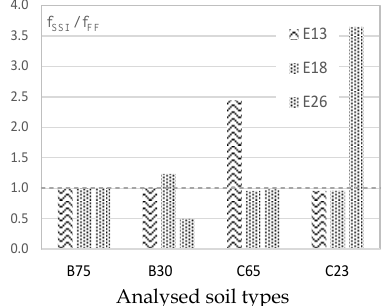
Figure 10. Comparison between the SSI (Soil-Structure Interaction) and the FF frequencies.